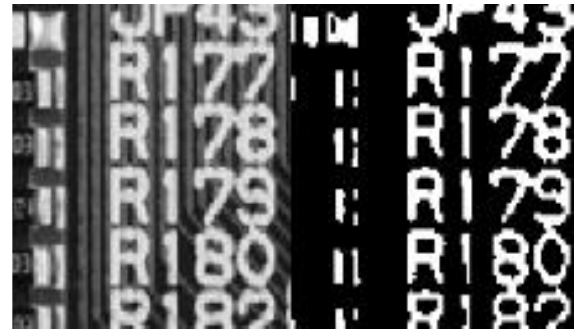
Figure 8 Binarized